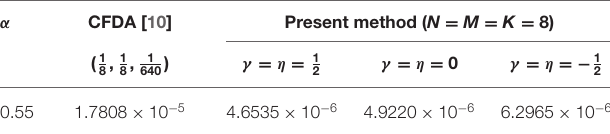
TABLE 5 | The L ∞ - errors for Example 5.2 with ω ( ν ) = δ ( ν − 1 + α ). α CFDA [10] Present method ( N = M = K = 8) , 1 , 1 ( 1 8 8 640